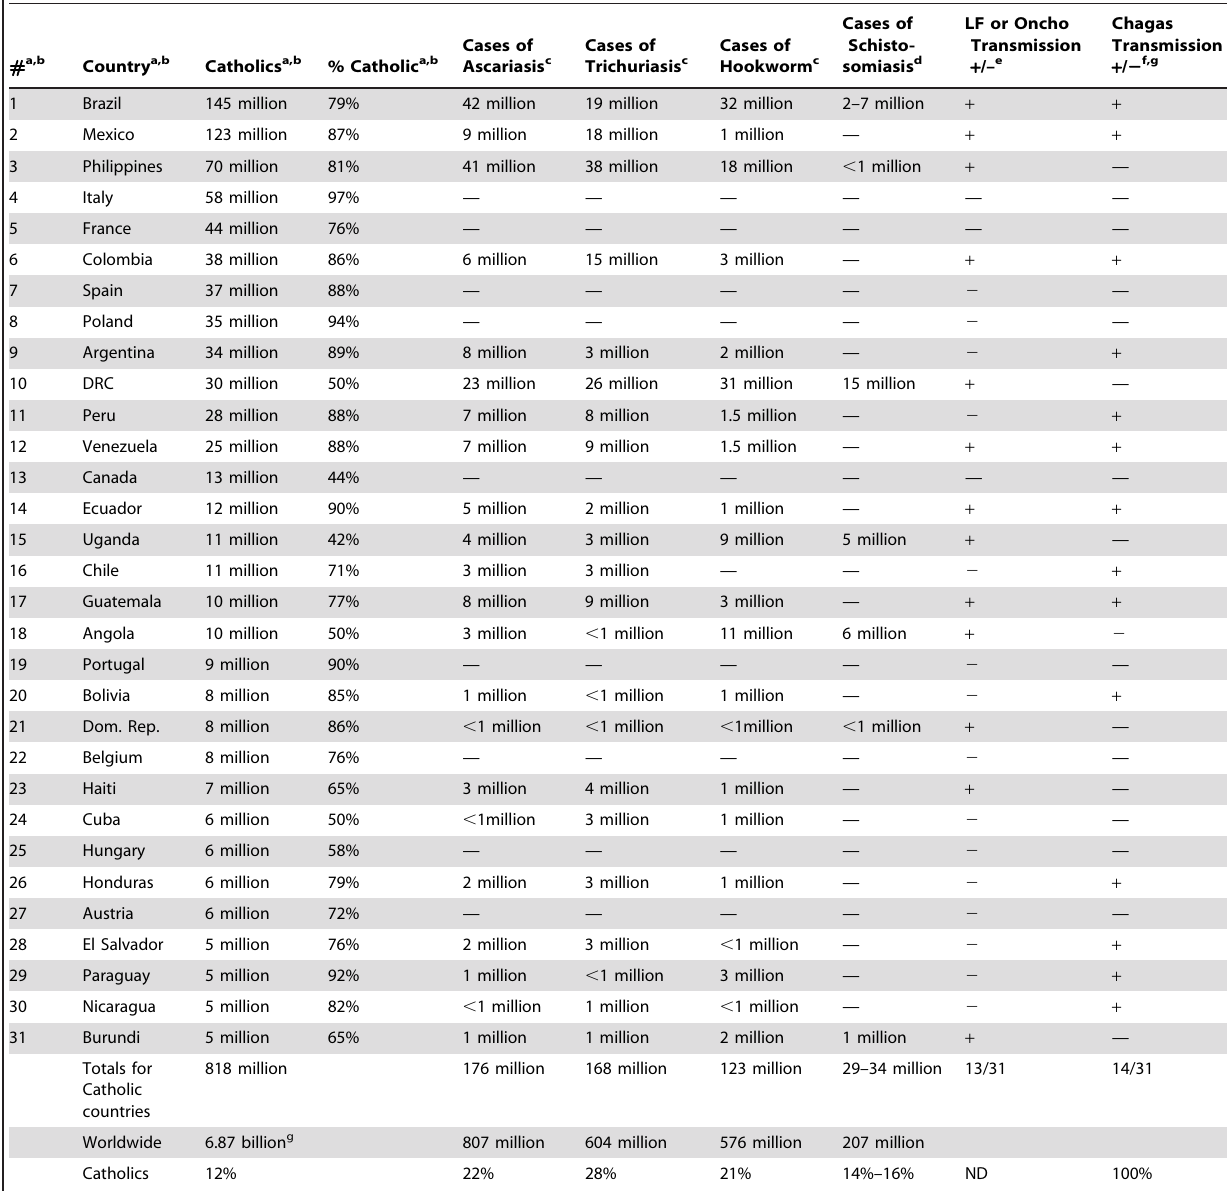
Table 1. NTDs in the Catholic